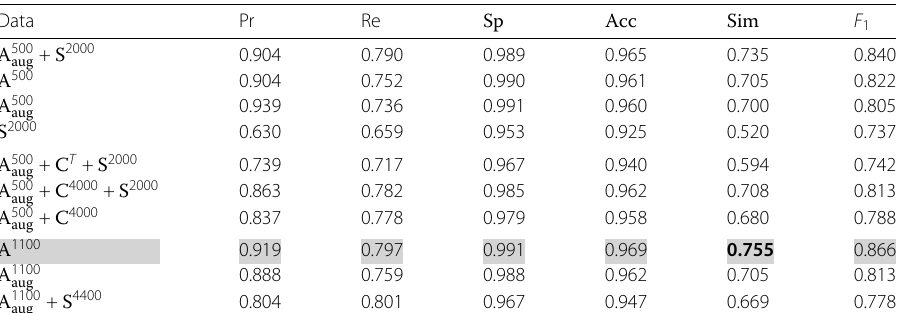
Table 8 Evaluation results for models trained on A 500 Online aug.